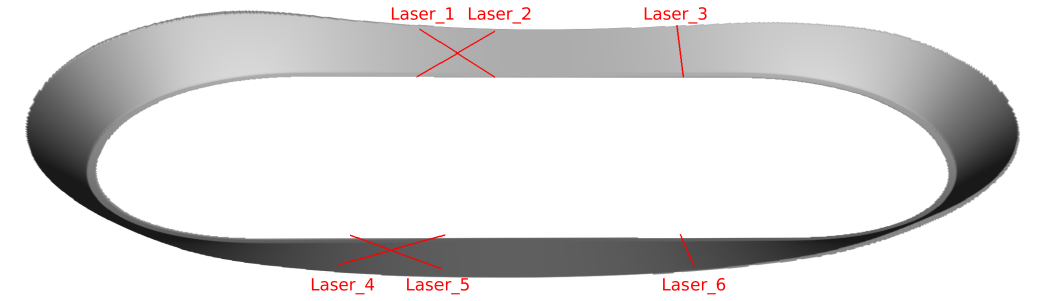
Figure 5. Ref. [11] Height map of the Sixdays track. The red lines show the laser